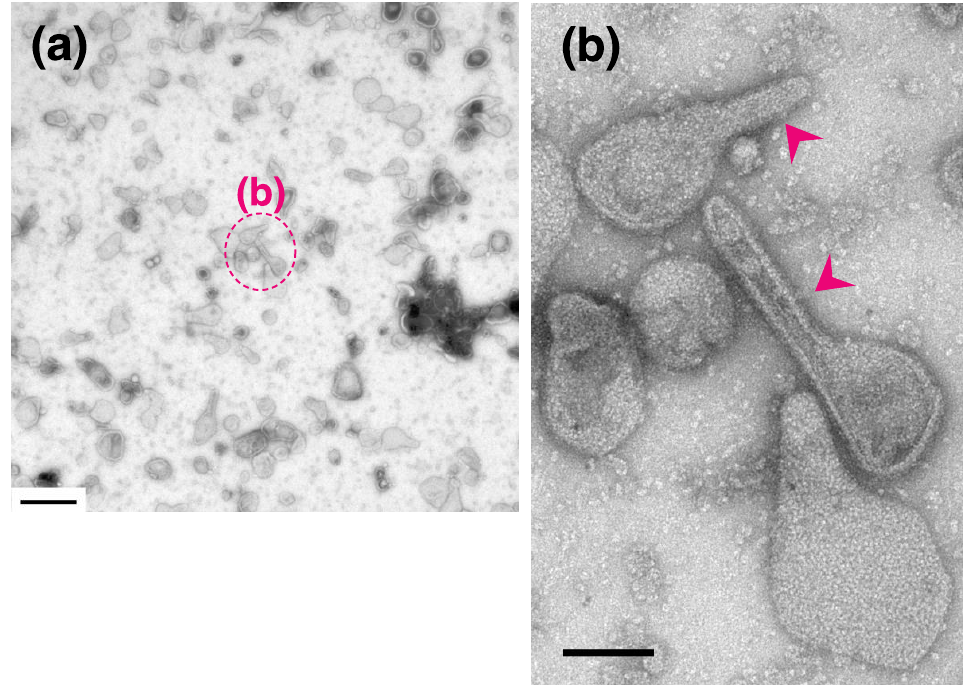
Figure 7. SR vesicles at 0.2 µM Ca 2+ in the presence of ATP at 0 °C. ( a ) Low magnification overview image of the vesicles. ( b ) Higher magnification image of the annotated area surrounding some elongated vesicles. The tightly elongated vesicles (arrowheads) did not include a crystal-array of particles. Scale bar in ( a ): 0.5 µm. Scale bar in ( b ): 100 nm.